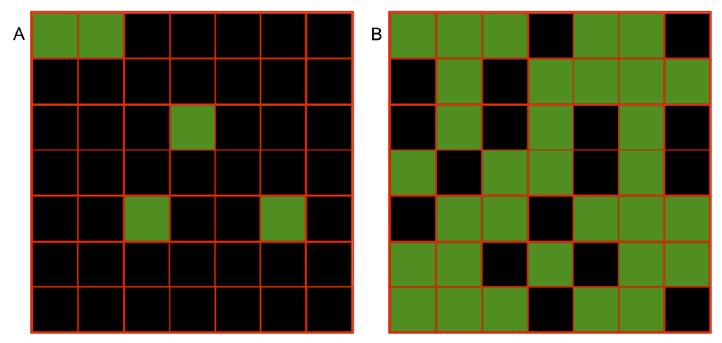
Figure 1. Examples of stimuli in the numerical judgment